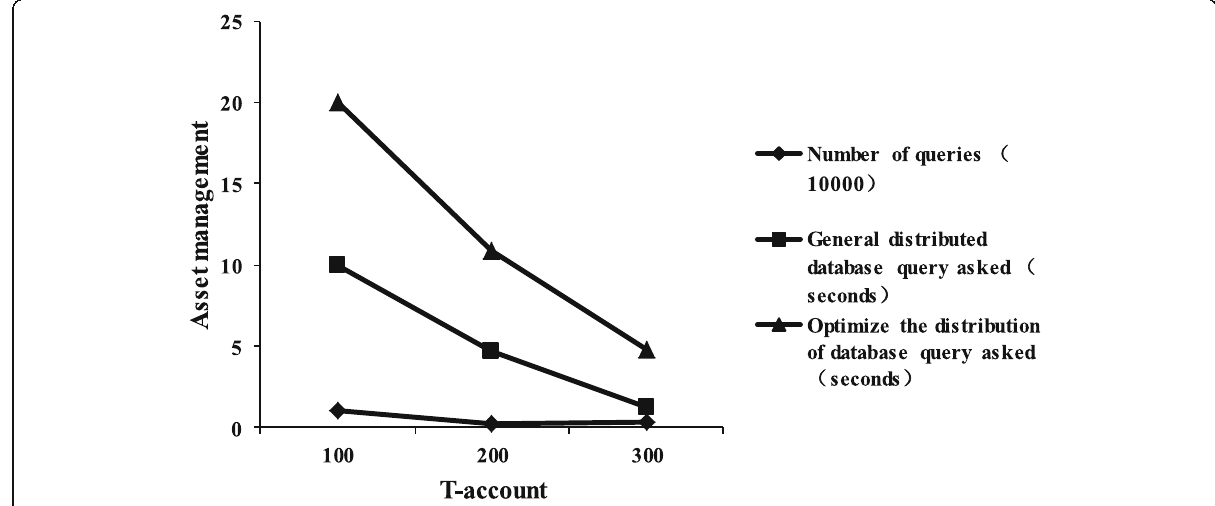
Fig. 5 Distributed database optimization query method comparison